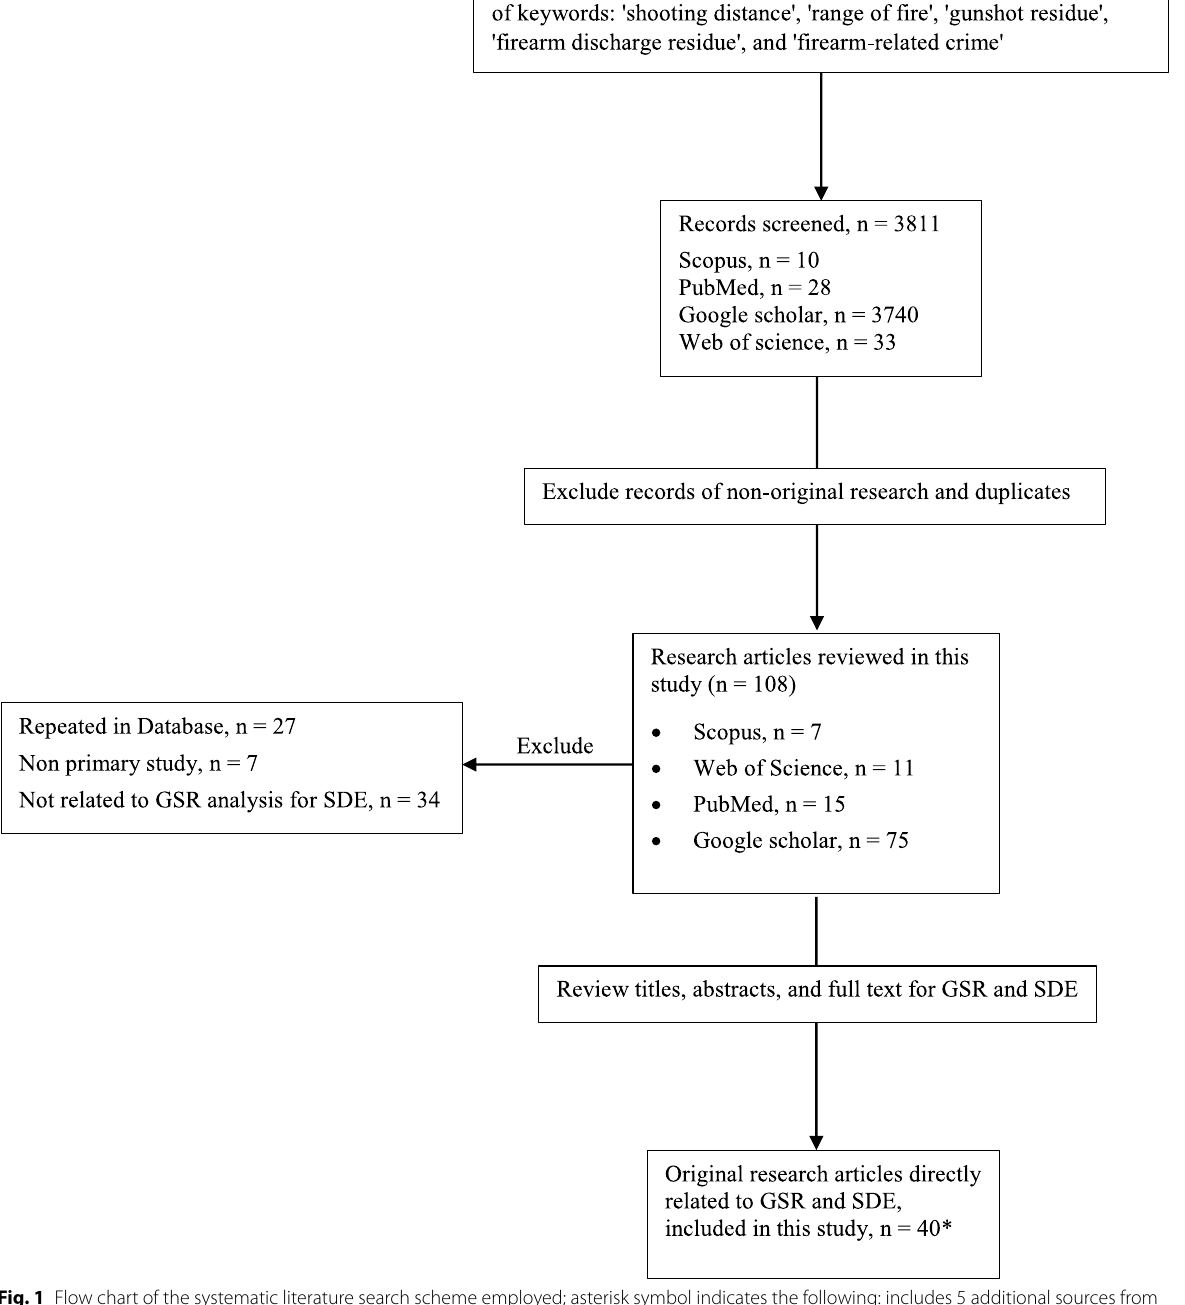
Fig. 1 Flow chart of the systematic literature search scheme employed; asterisk symbol indicates the following: includes 5 additional sources from reference